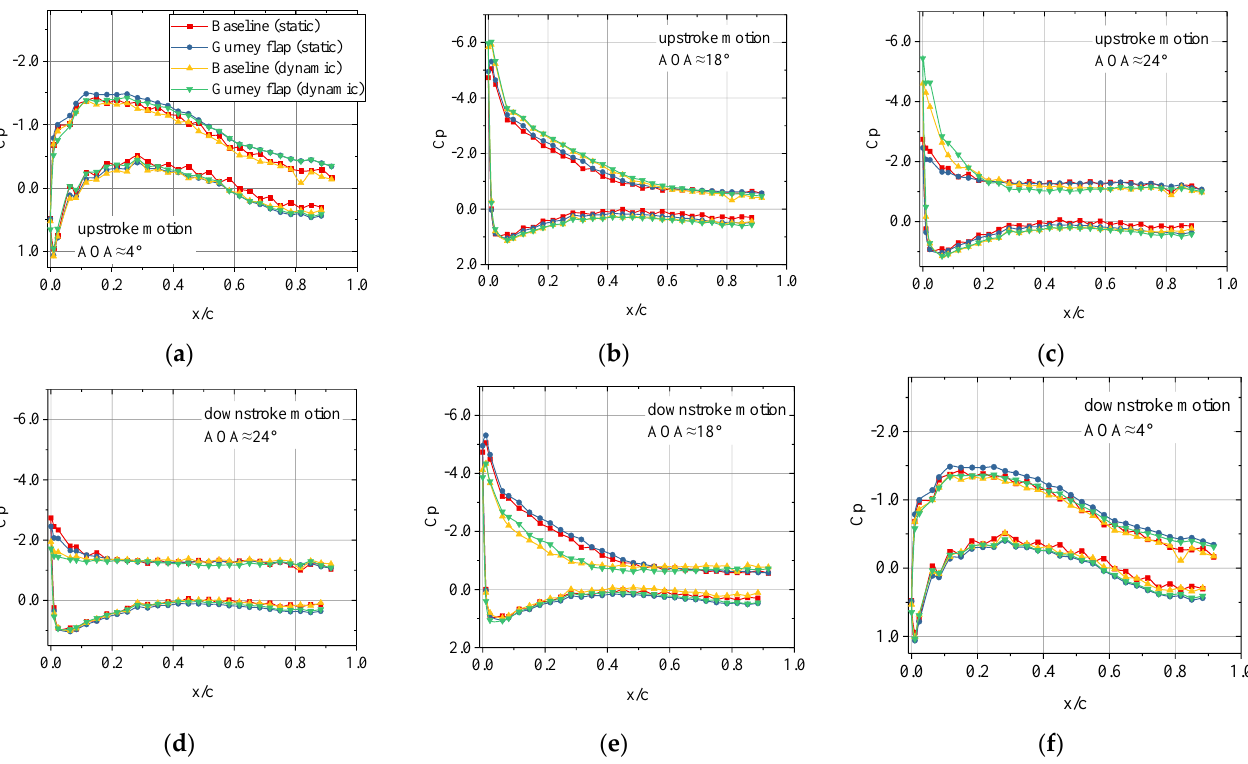
Figure 8. Comparison of the pressure coefficient measured for A = 12.5, α mean = 12.5 and K = 0.0167 in a period at T.I. of 10.18%. ( a ) upstroke, AOA ≈ 4°; ( b ) upstroke, AOA ≈ 18°; ( c ) upstroke, AOA ≈ 24°; ( d ) downstroke, AOA ≈ 24°; ( e ) downstroke, AOA ≈ 18°; ( f ) downstroke, AOA ≈ 4°.